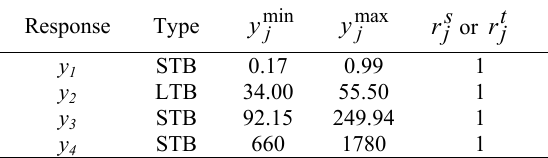
Table 15. Type of response and their